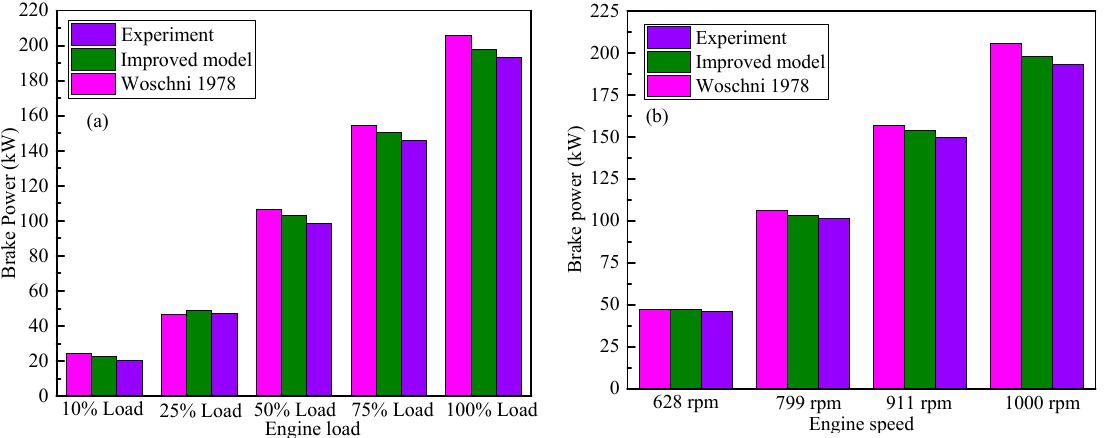
Figure 6. Comparisons of brake power under different load conditions.